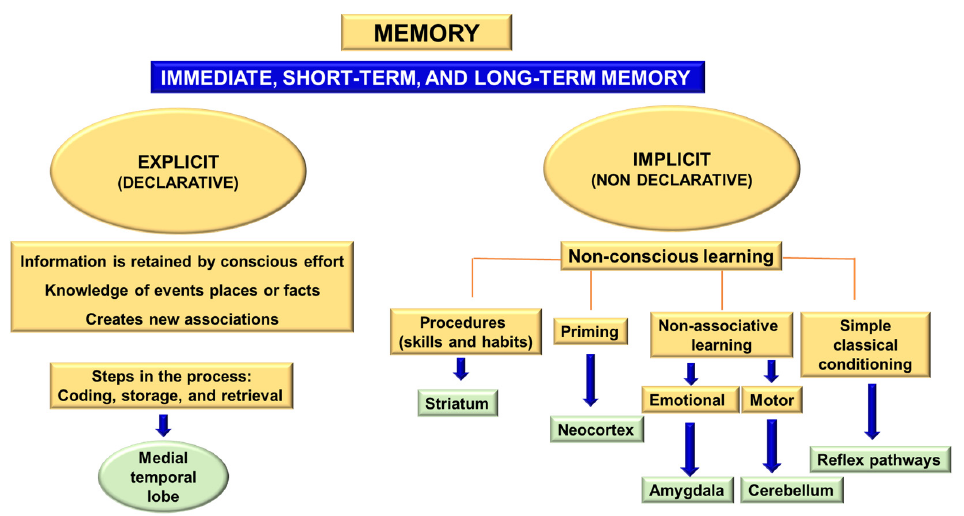
Figure 1. Types of memory and related brain structures. Depending on how the information is received and stored, two main types of memory can be distinguished: implicit memory, which does not require conscious learning, and explicit memory, which is the product of conscious cognitive effort.